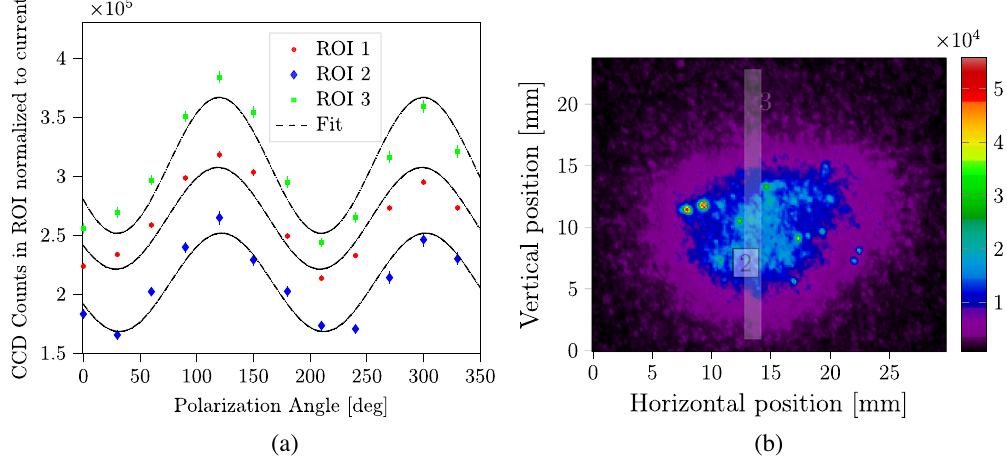
FIG. 12. (a) OTR light output from an aluminum target as a function of polarizer angle. 120° and 300° on the polarizer corresponds to the plane of incidence. (b) The different regions of interest for calculated counts are shown in the image with hotspots due to the surface nonuniformities. ROI 1 corresponds to the shown full image while ROI 2 and ROI 3 are smaller sections as